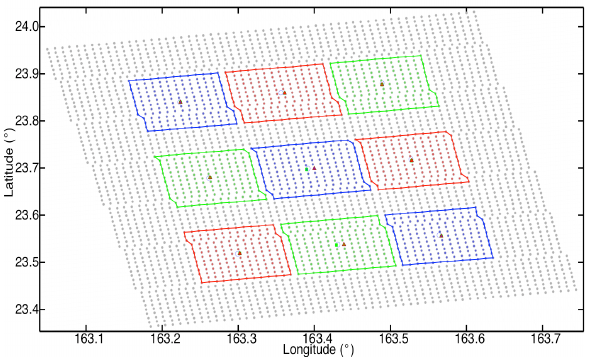
Figure 1. The method of the AIRS vs MODIS collocation where the small solid dots (black or colored inside the Fig. 1. The method of the AIRS vs. MODIS collocation where the boxes) are the center locations of MODIS pixels; the blue circles are the center locations of AIRS pixels; the green squares are the collocated nearest MODIS pixels; and the triangles are the center locations of the boxes used for all small solid dots (black or colored inside the boxes) are the center the MODIS pixels in each AIRS pixel. locations of MODIS pixels, the blue circles the center locations of AIRS pixels, the green squares the collocated nearest MODIS pix- els, and the triangles the center locations of the boxes used for all the MODIS pixels in each AIRS pixel.